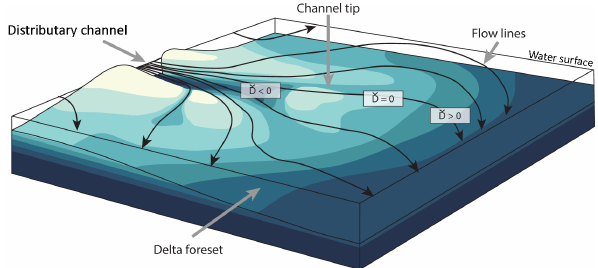
Figure 2. Schematic diagram of delta front morphology and streak line behavior. The color map shows topography with dark colors representing deep areas and light colors representing shallow or subaerial areas. Streak lines are shown as black solid lines. The FD2C method takes advantage of flow direction divergence ( ˇ D < 0) through the shoaling reach of the channel and lateral flow direc- tion convergence ( ˇ D > 0) on the basinward sloping delta front. The channel tip occurs roughly where ˇ D transitions from negative to positive.